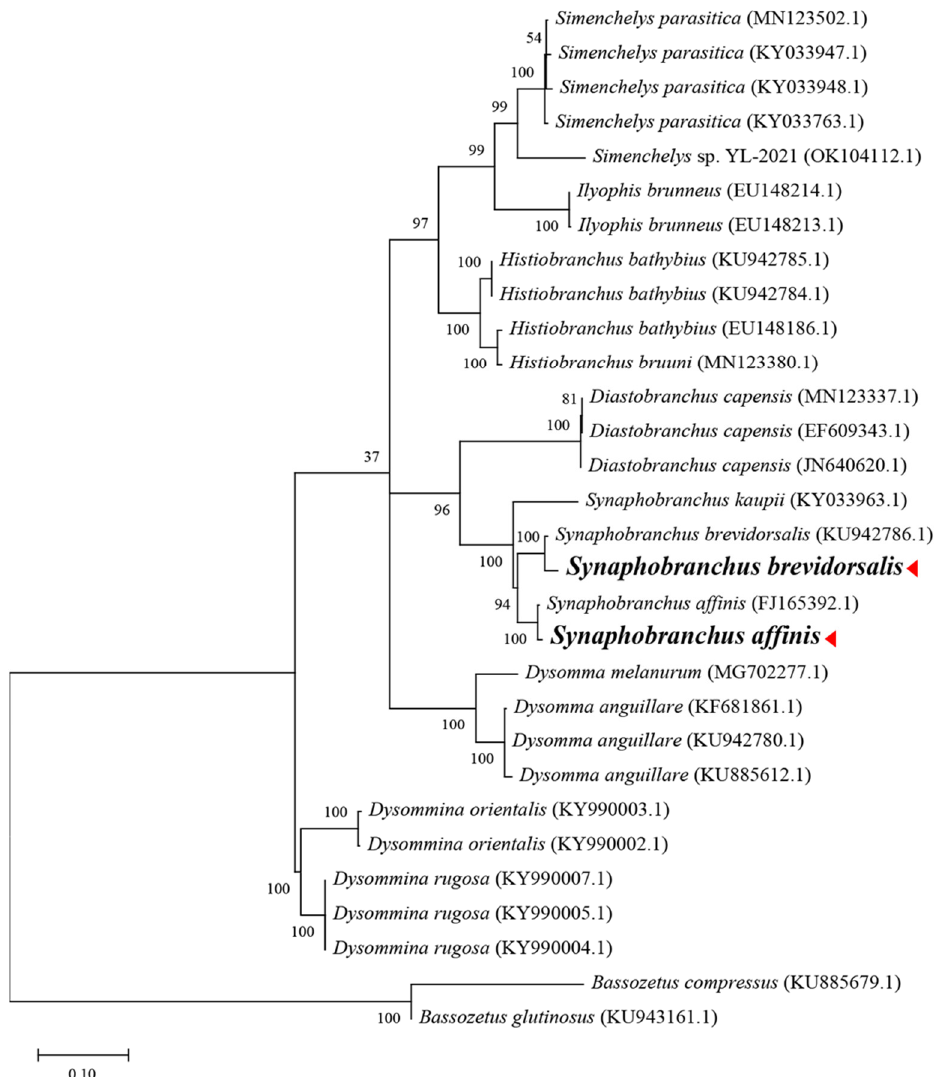
Figure 2. Phylogenic tree based on mitochondrial COI using the MEGA software (ver. 10.0.1). Phylogeny was generated using maximum likelihood estimation. Published mtDNA COI sequences from the Synaphobranchidae eel family were used as reference. The red triangles indicate the Synaphobranchus species analyzed in this study.